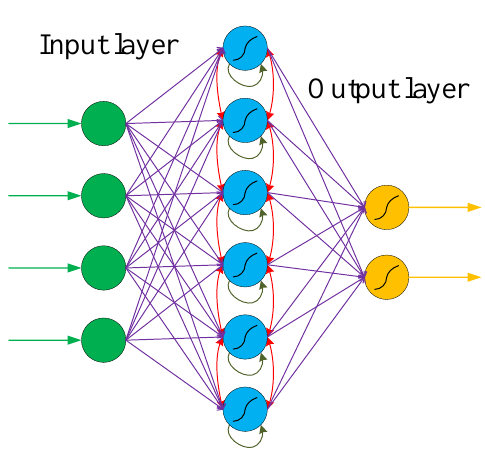
Figure 4. Typical structure of an RNN.